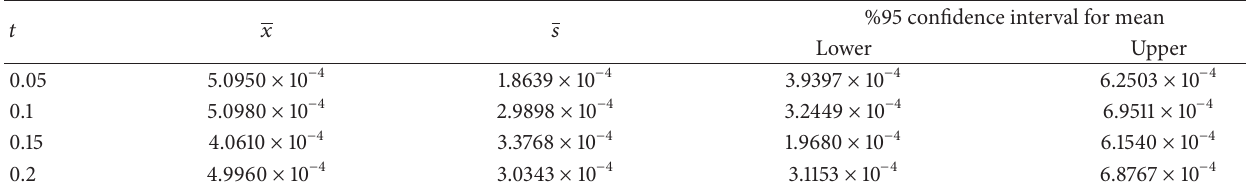
Table 5: Mean, standard deviation, and confidence interval for numerical solution mean ( 𝑇 = 0.25 , 𝐻 = 3/4 ).